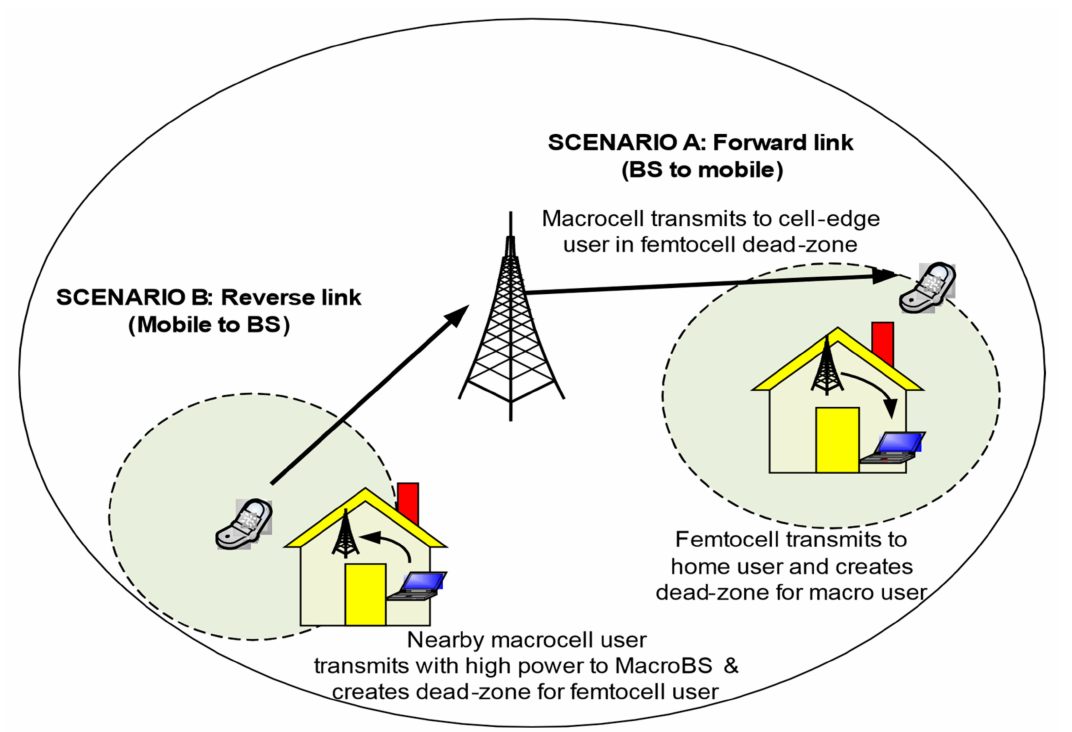
Figure 3. Femtocells configuration showing dead zones in wireless networks.